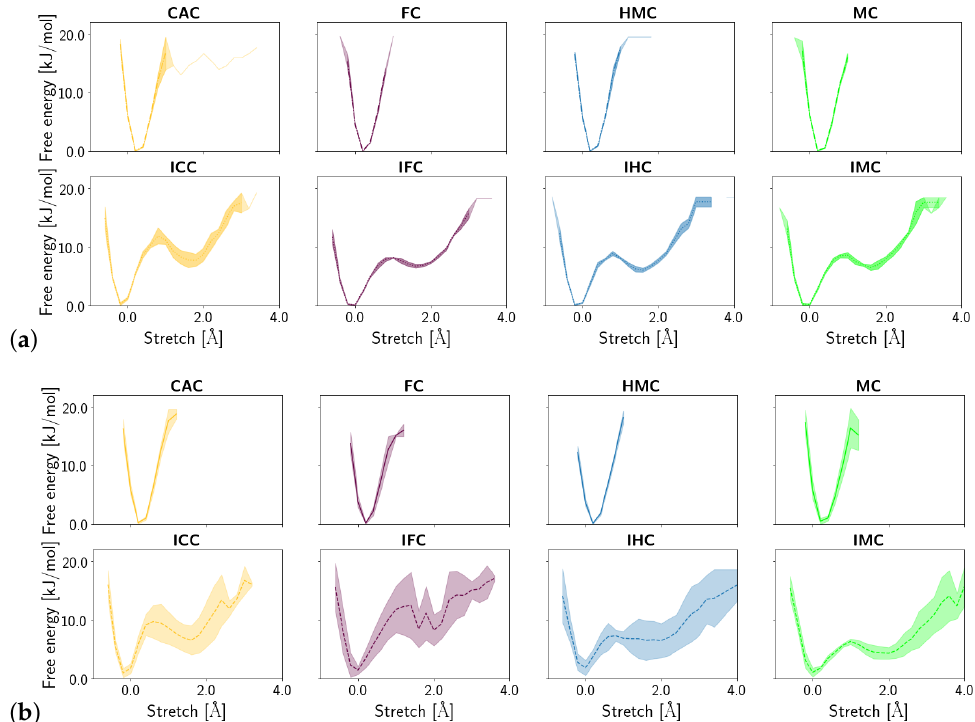
Figure 6. Free energy profiles of the stretch displacement of the oxidised methyl-cytosine:guanine (G:XC) pair ( a ) in the free DNA in amino form ( top ) and imino form ( bottom ) and ( b ) in the DNA complexed to TDG in amino ( top ) and imino ( bottom )